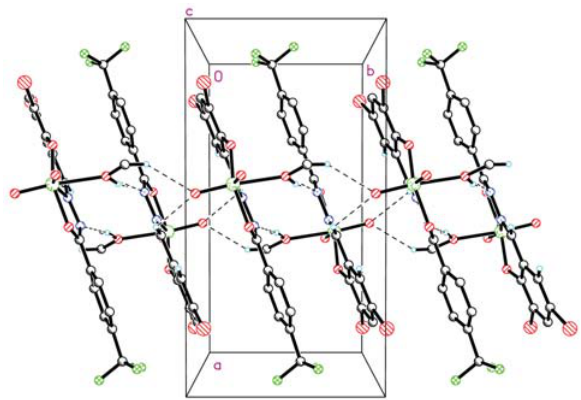
Figure 3. Hydrogen bond (dashed lines) linked structure of 1 , vie- wed down the c